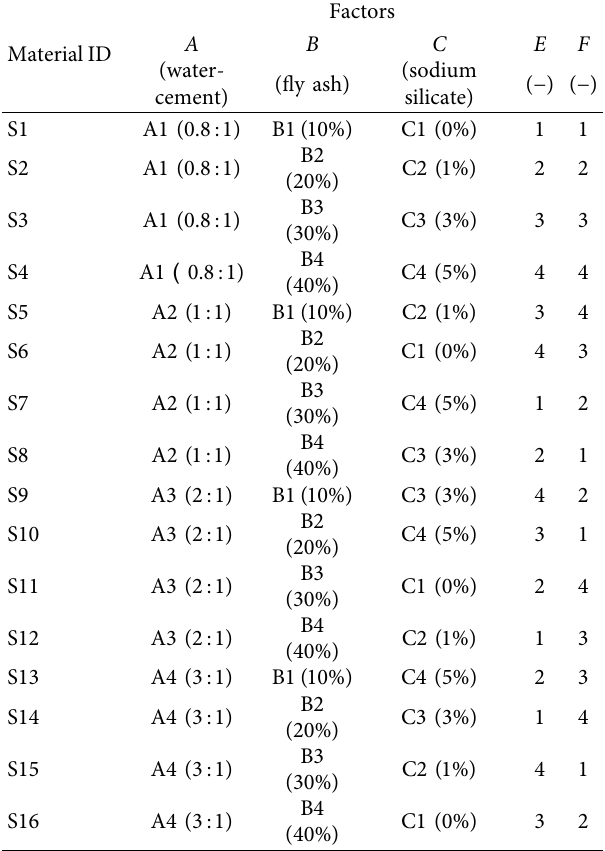
Table 1: The design of orthogonal experiment according to the L 16 (4 5 )